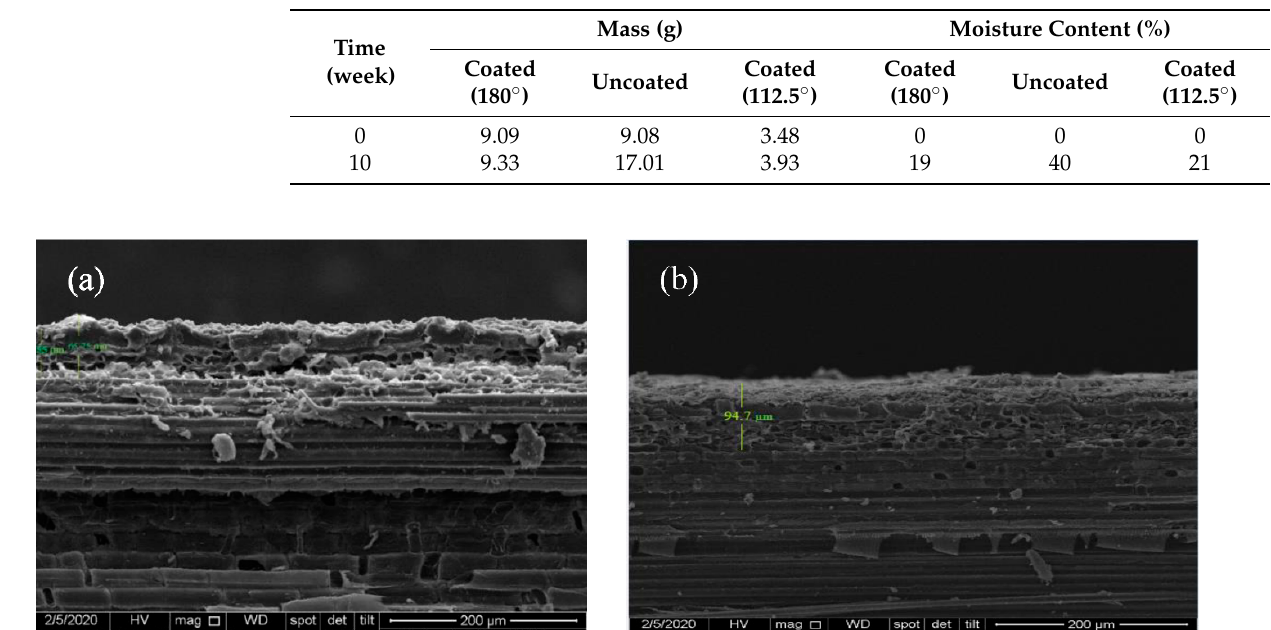
Figure 16. Thickness of coated bamboo with modified silica–HMDS coating with contact angles of 112.5° ( a ) and 180° ( b ).